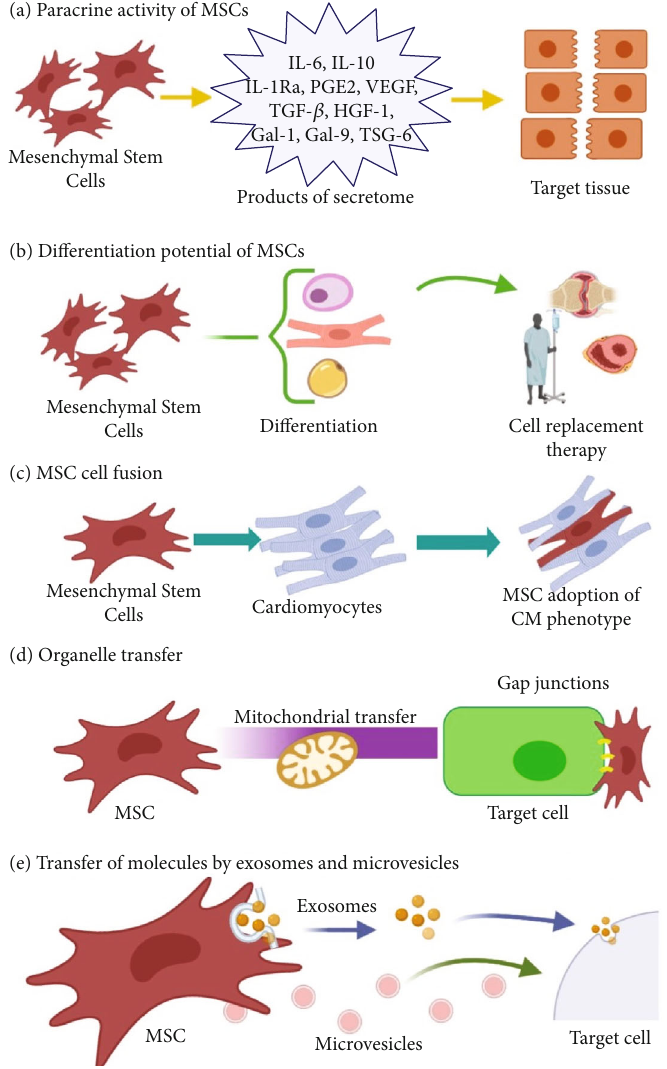
Figure 2: Mesenchymal stem cell therapeutic mechanisms: (a) the paracrine activity of MSCs, (b) di ff erentiation potential of MSCs, (c) MSC cell fusion, (d) organelle transfer, and (e) transfer of molecules by exosomes and microvesicles. Created with